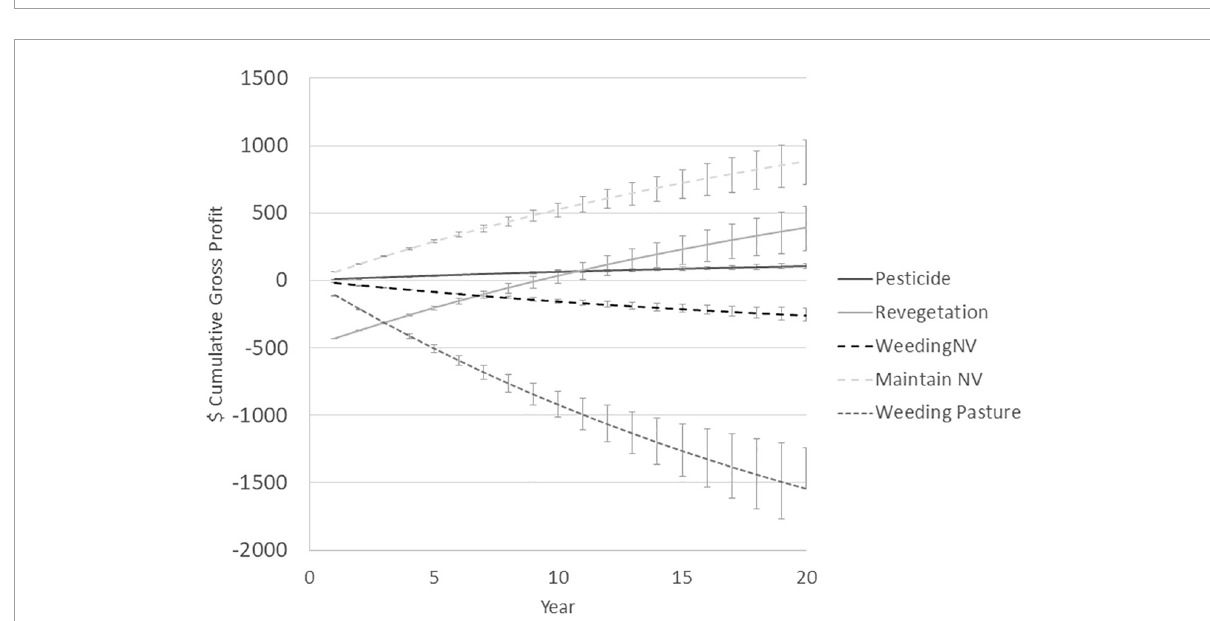
FIGURE6 Mean cumulative gross profit for canola across the landscape for mean parameter values of each management scenario over time, including a discount rate of 4% on the benefit and cost (error bars indicate a discount rate of 2 and